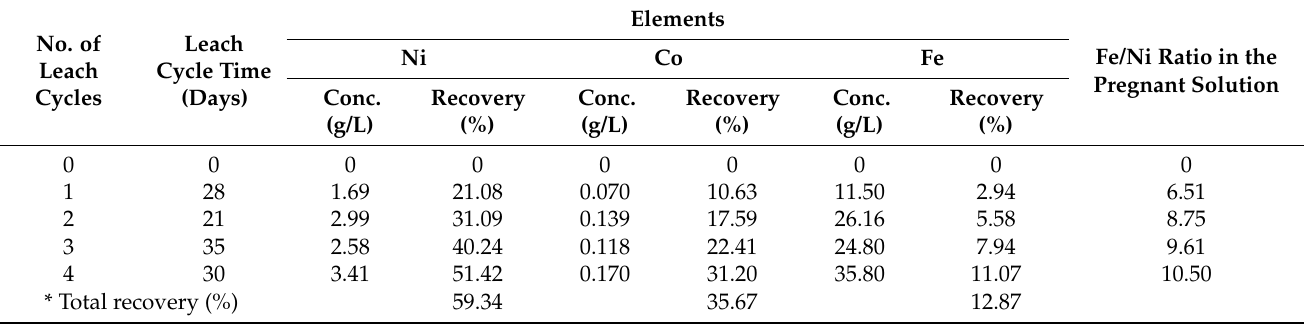
Table 4. Analysis of the pregnant solution and percent extraction of metal cations.